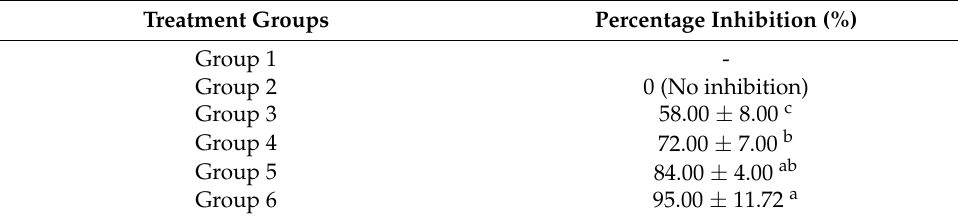
Table 3. Anti-hemorrhagic activity of M. oleifera extract. Treatment Groups